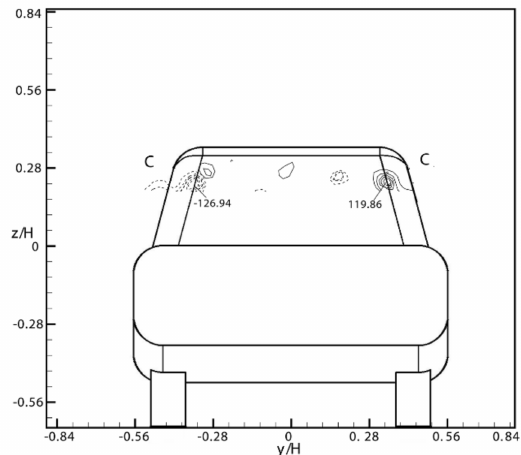
Figure 4. Iso-contours of time-averaged streamwise vorticity, ω x in the y–z plane at x/H = − 0.7. Min- imum and incremental values of vorticity are ω x,min = − 45.221 s − 1 , 27.221 s − 1 , and ∆ ω x = 20.430 s − 1 , respectively.